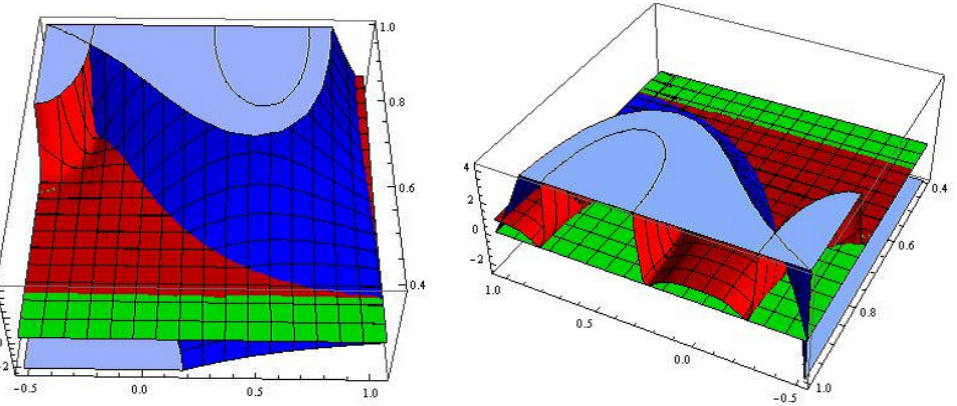
det W (the red domain), the plane x 3 = 0 (the green domain), and x 3 = Figure 5. The graph of x 3 = − ( A + √ 3 iB ) ( i C + D ) ( A + √ 3 iB ) ( i C + D ) (the blue domain) in {(cid:60) }{(cid:61) } − {(cid:61) }{(cid:60) }